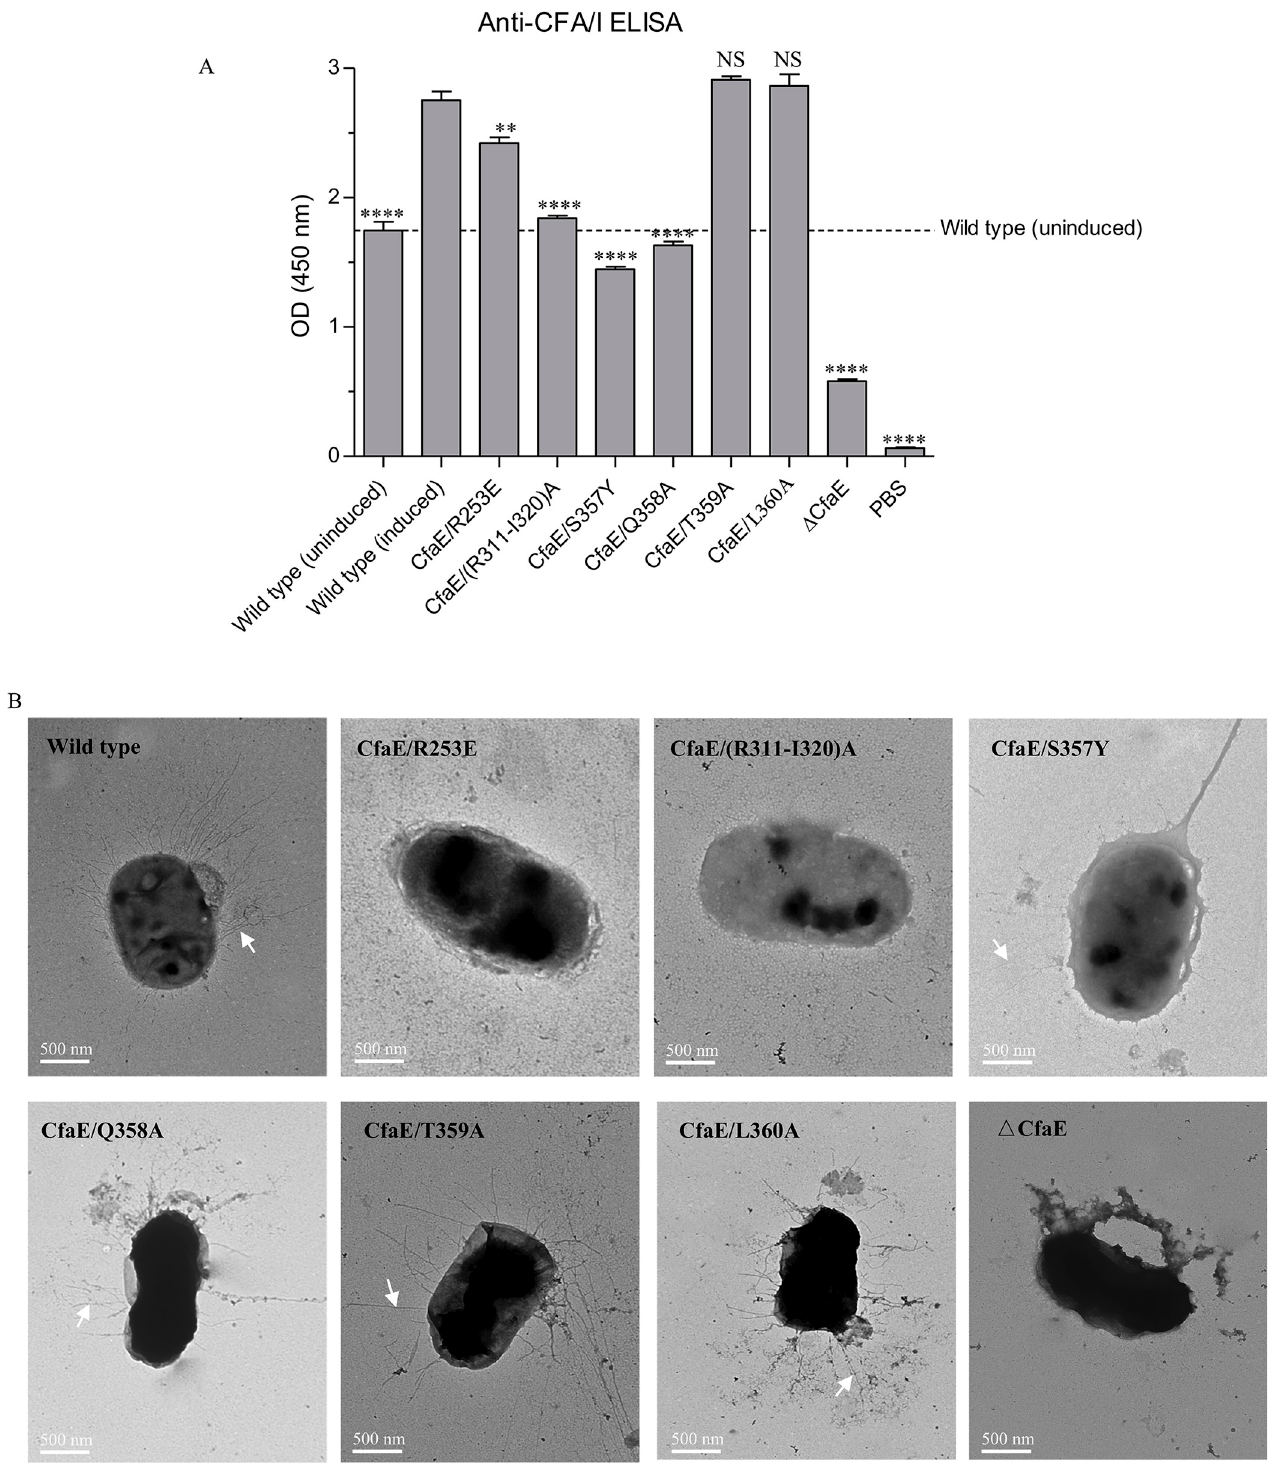
Fig 4. Effects of CfaE mutations on CFA/I fimbriae assembly and function. (A) The amount of CFA/I fimbriae containing CfaE variants expressed on the bacterial surface was detected by bact-ELISA using a specific antibody against subunit CfaB after the induction of CFA/I operon. (B) Negative stain EM images of CFA/I on the surface of bacteria containing CfaE mutations. The scale of each EM picture is indicated. The white arrow heads in Panel A indicate CFA/I fimbriae. The scale bar is 500 nm.